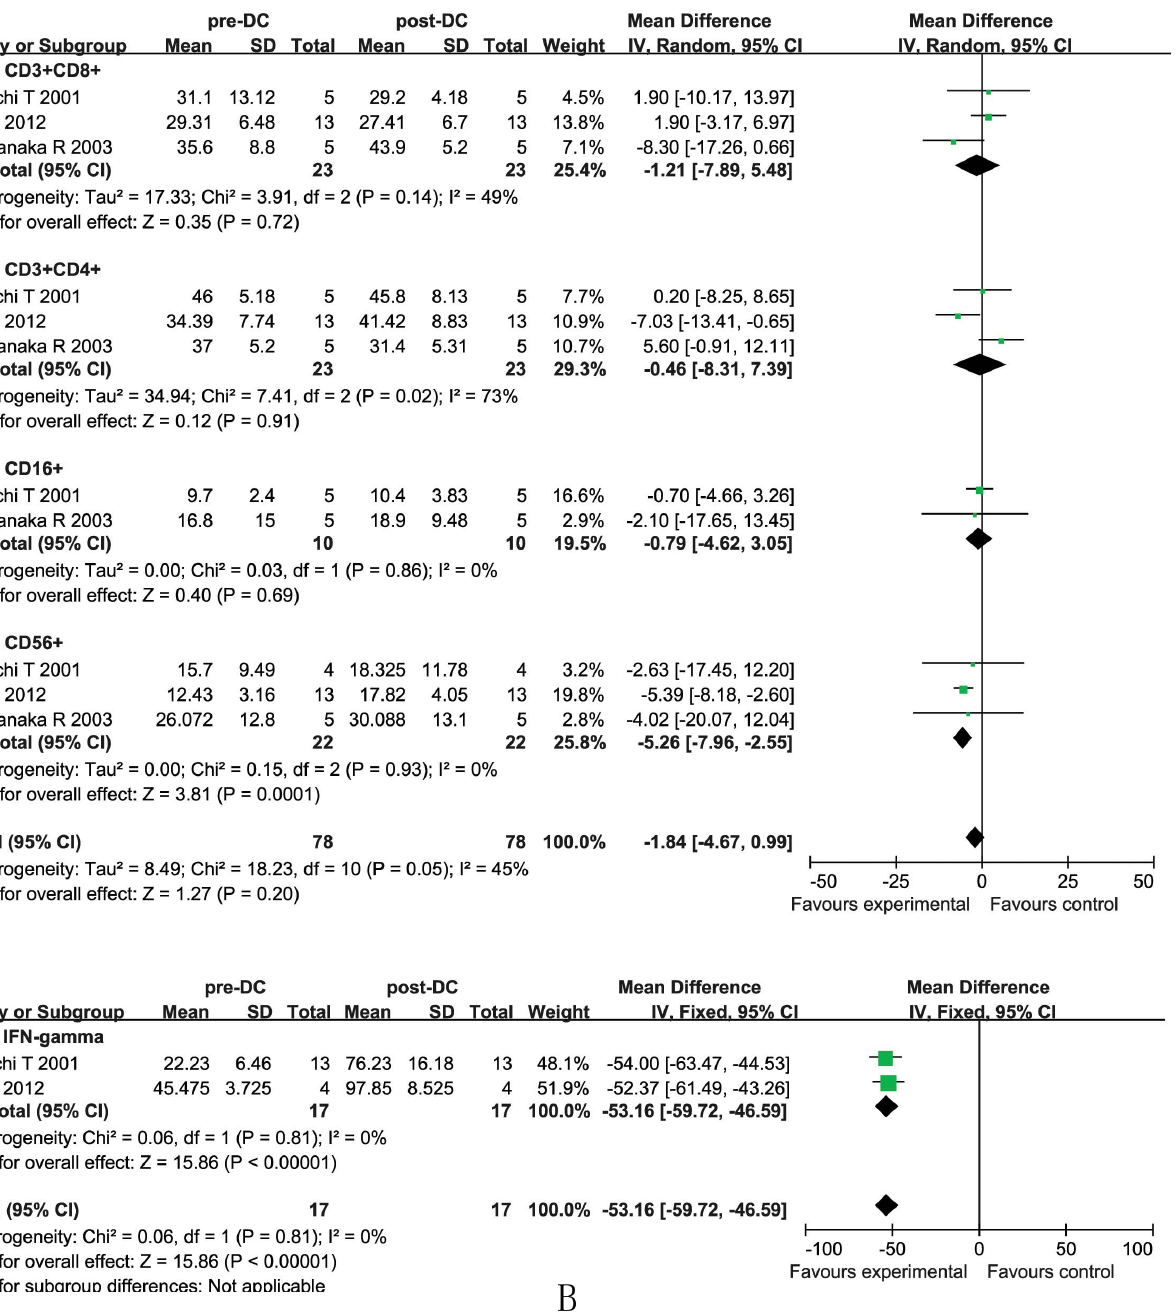
Figure 5. Forest plot for the immunophenotype (A) and immune cytokine (B) assessment. The data were collected from the patients before and after DC treatment. The random and fixed effects meta-analysis model (Mantel-Haenszel method) was used in this